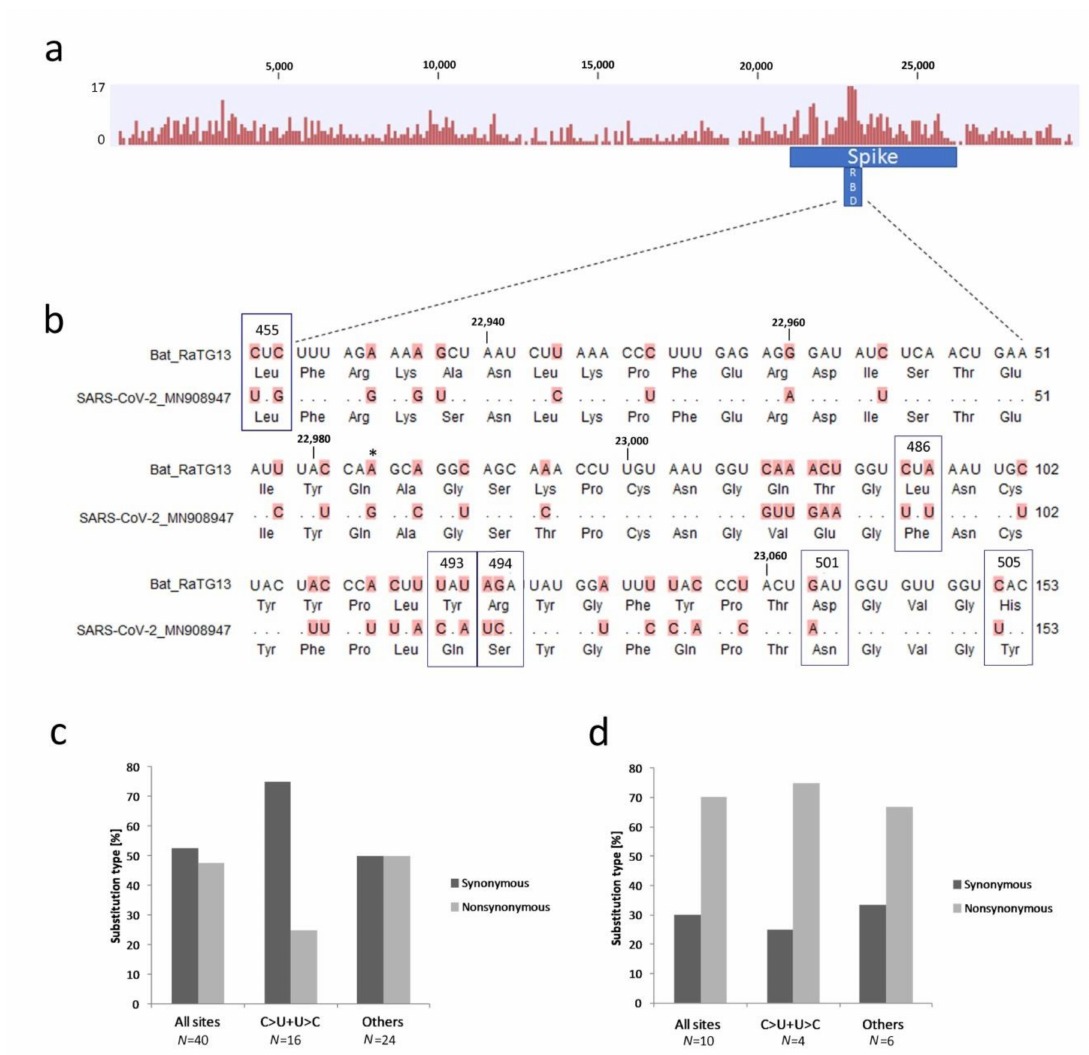
Figure 4. Sequence variation between the bat RaTG13 and Sars-CoV-2 (MN908947) genomes. ( a ) A graphical representation of SNVs. The height of the columns reflects the number of SNVs in a 100-nt sliding window. ( b ) Alignment of the ACE2 receptor-binding domains (RBD). Coordinates are according to a spike protein reading frame in the SARS-CoV-2 genome. The direction of mutations is from the bat RaTG13 to human SARS-CoV-2 sequence. The di ff erences between SARS-CoV-2 and bat RaTG13 sequences are highlighted. Amino acids in a contact zone are boxed. The site at position 22984 (asterisk) was also polymorphic among human SARS-CoV-2 isolates (Table S4 sheet 3). The occurrences of distinct substitutions in synonymous and nonsynonymous sites in ( c ) the whole ACE2 receptor-binding domain (RBD) and ( d ) a contact zone